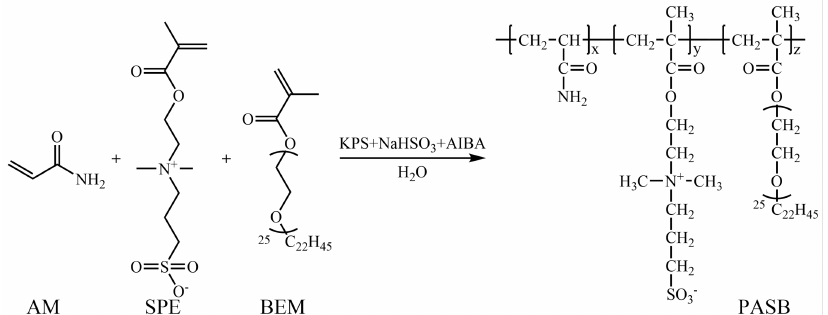
Figure 1. Synthetic route of PASB copolymers.